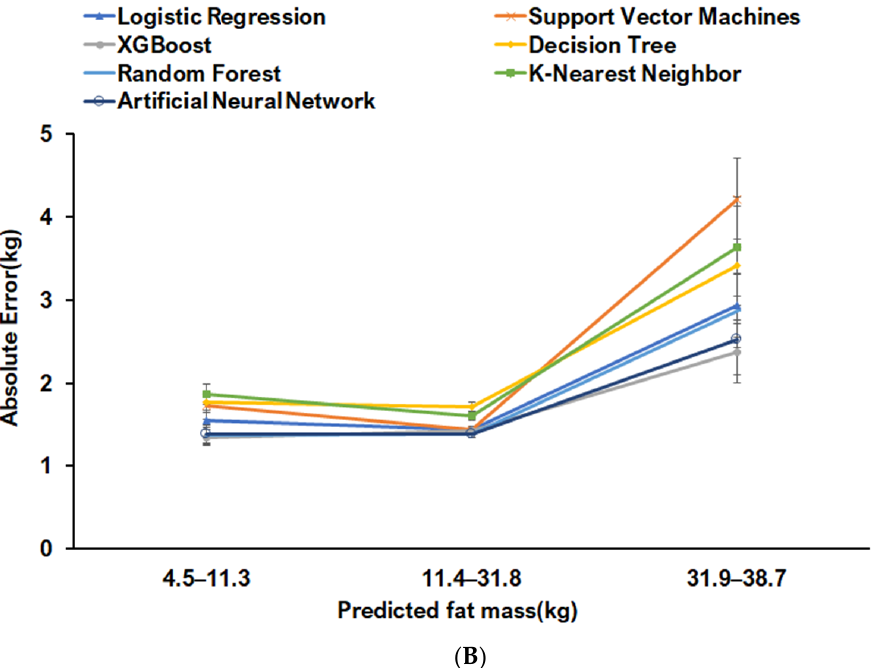
Figure 3. Absolute errors of SMM prediction with ranges in the test set for the seven machine learning algorithms. ( A ) Skeletal muscle mass (SMM); ( B ) fat mass (FM). Absolute errors were calculated by subtracting actual values from predicted values. The SMM and FM were divided into quintiles and Q1, Q2–Q4, and Q5. The absolute errors of predicted SMM and FM by XGBoost and ANN models were calculated in each of these three ranges.